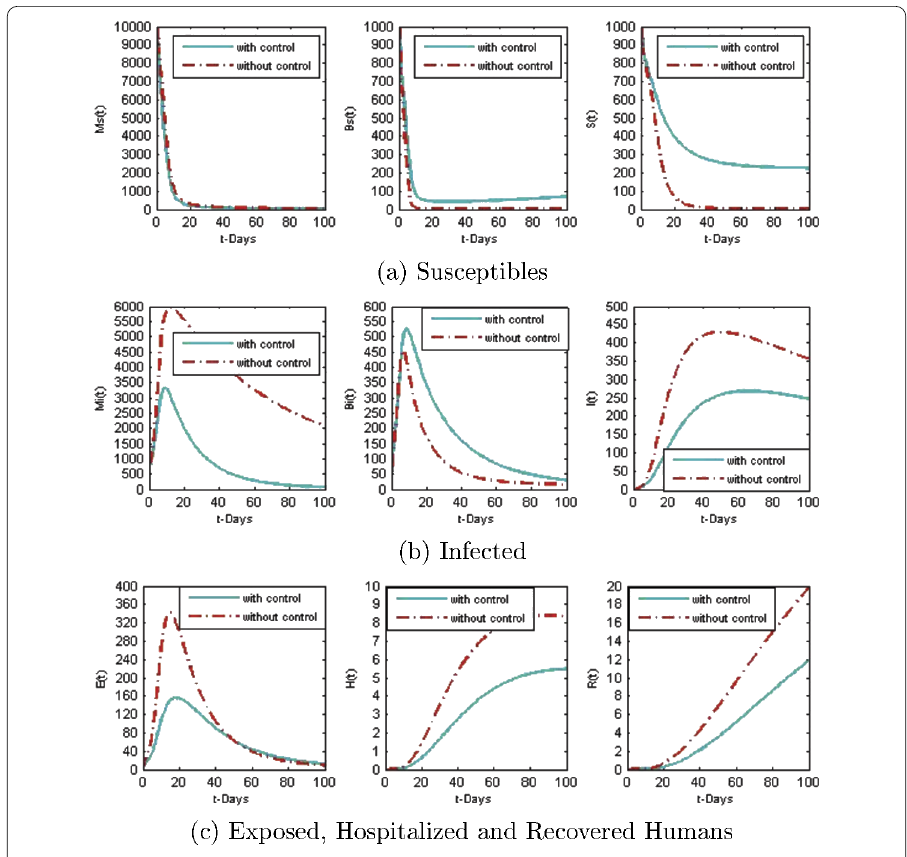
Figure 5 The approximate solutions of the fractional delay optimal control problem by using NSFDM. When 0 ≤ u 1 ≤ 0.8, 0 ≤ u 2 ≤ 0.5, and without control (i.e., u 1 = u 2 = 0) with d = 1 at α = 0.90, and (cid:7) t = 1